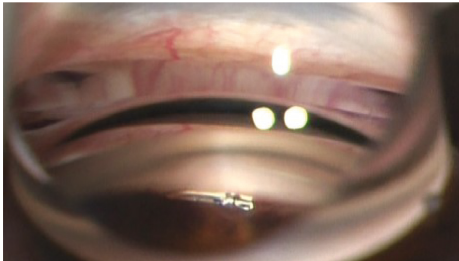
Figure 2: Aqueous veins visible before balanced saline solution placed through the Hydrus stent.